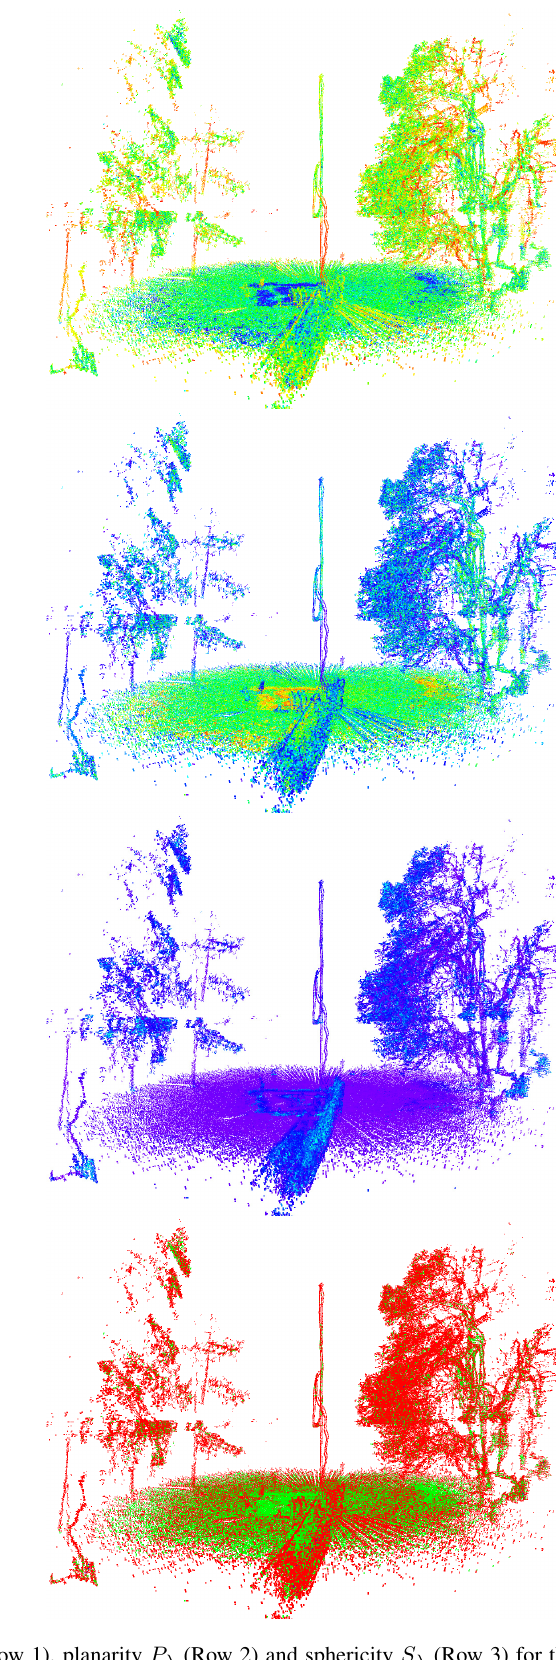
Figure 6. Behavior of the dimensionality features of linearity L λ (Row 1), planarity P λ (Row 2) and sphericity S λ (Row 3) for the neighborhoods N k =50 (left) and N k (right): the color encoding indicates high values close to 1 in red and reaches via yellow, green, opt cyan and blue to violet for low values close to 0 . The maximum value of these features indicates the dominant behavior of a 3D point (Row 4): a linear behavior is indicated in red, a planar behavior is indicated in green and a volumetric behavior is indicated in